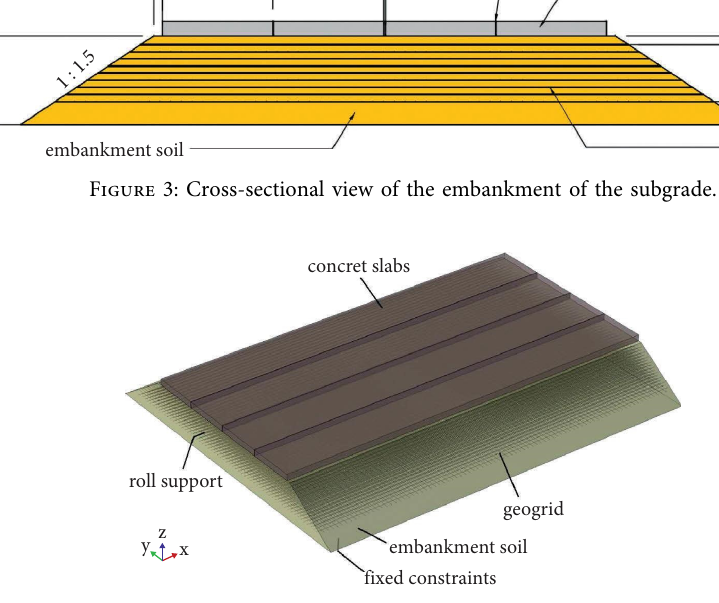
Figure 4: Finite element model and schematic diagram of boundary